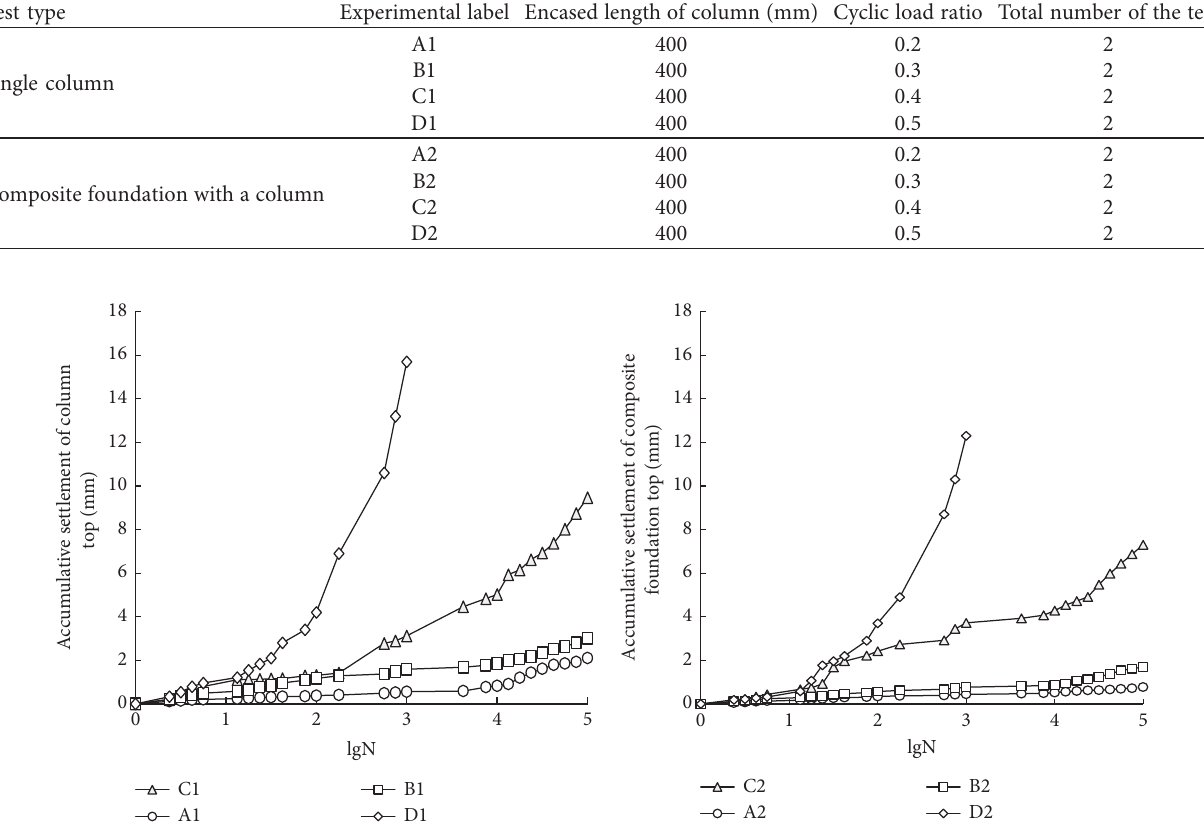
Table 4: Plate loading tests on the composite foundations.